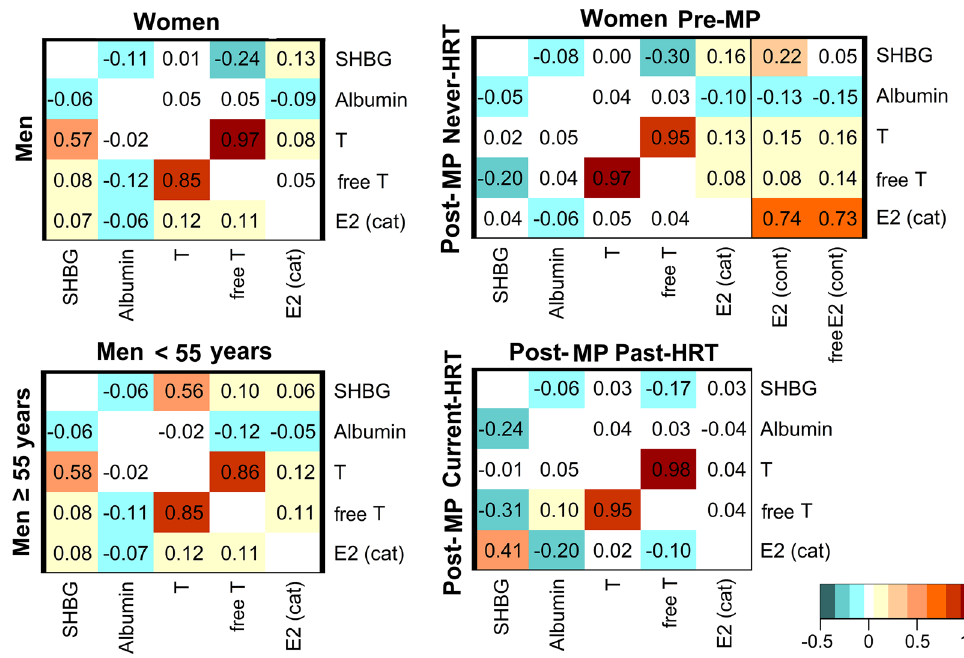
Figure 5. Associations between sex steroids and their binding proteins. E2 ( cat ) oestradiol as a binary variable (undetectable/detectable), E2 ( cont ) oestradiol as a continuous variable (with imputed values below the lower limit of detection), free E2 free oestradiol, free T free testosterone, HRT hormone replacement therapy, Post-MP post-menopausal, Pre-MP pre-menopausal, SHBG sex hormone binding globulin, T testosterone. Pearson partial correlation coefficients were adjusted for “a body shape index” (ABSI), hip index (HI), body mass index (BMI), height (sex-specific z-scores, continuous scale), age at enrolment, weight change during the last year preceding enrolment, smoking status, alcohol consumption, physical activity, Townsend deprivation index (continuous), time of blood collection (continuous), fasting time (continuous), use of cholesterol lowering drugs (except Pre-MP), and in women age at the last live birth, oral contraceptive use, bilateral oophorectomy (except Pre-MP) and, additionally, menopausal status and HRT use (women overall), time of the menstrual period (Pre-MP), duration of use and time since stopped HRT (Past-HRT), duration of use and type of HRT (Current- HRT). Participant groups are defined in Supplementary Fig. S1. The correlation coefficient for total vs free oestradiol in Pre-MP women was 0.98. All p-values were p < 0.0001, except for SHBG vs testosterone in women (overall, p = 0.016), Pre-MP (p = 0.87) and Post-MP Current-HRT (p = 0.16), and for oestradiol vs testosterone in women Post-MP Current-HRT (p =